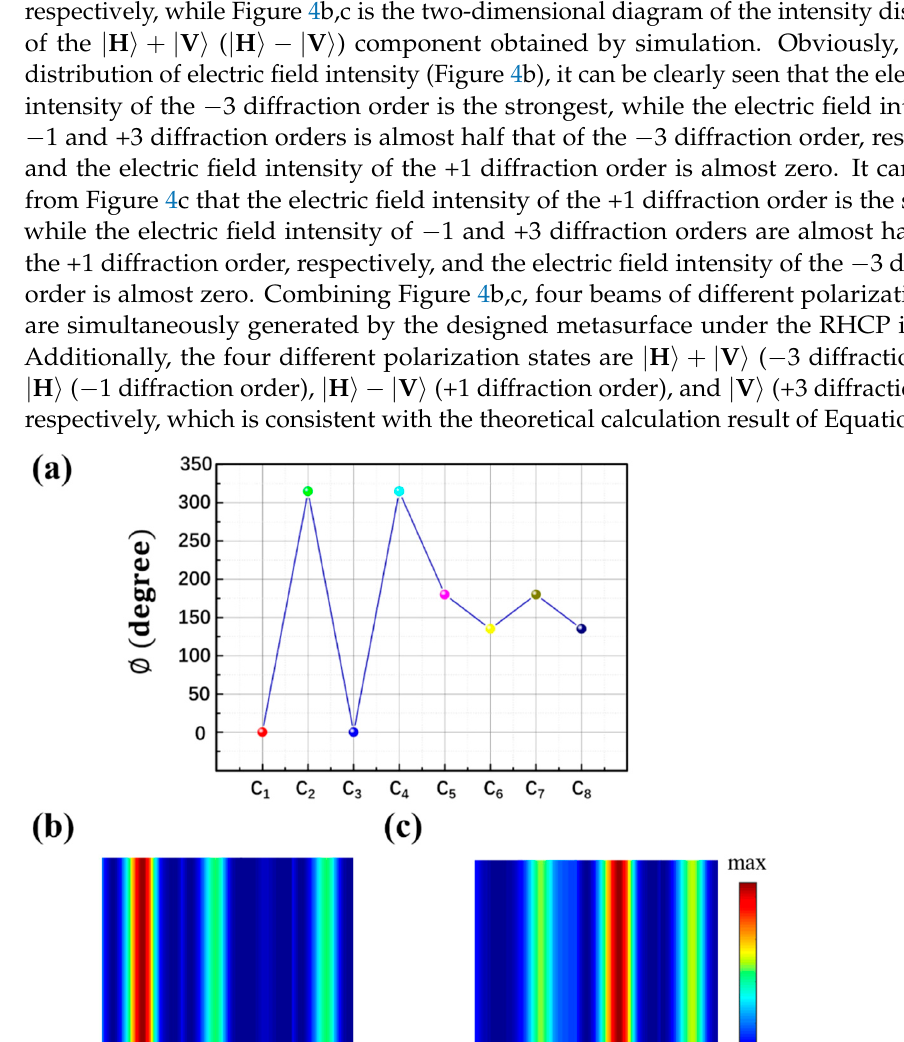
Figure 4. Under RHCP incidence, ( a ) the phase distribution of 8 units, ( b ) the intensity profile of | H (cid:105) + | V (cid:105) component, and ( c ) the intensity profile of | H (cid:105) − | V (cid:105) component are